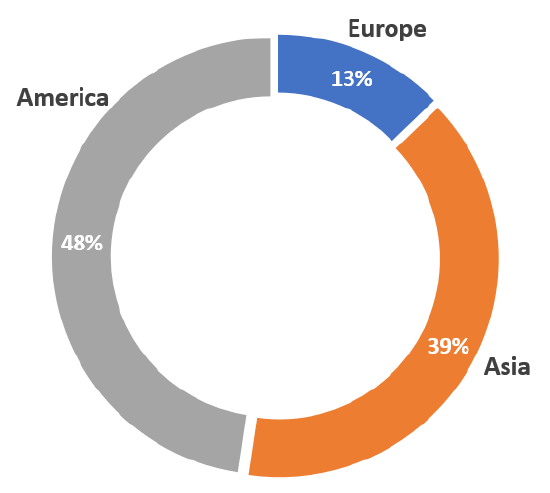
Figure 6. Location distribution for the commercial devices marketed.